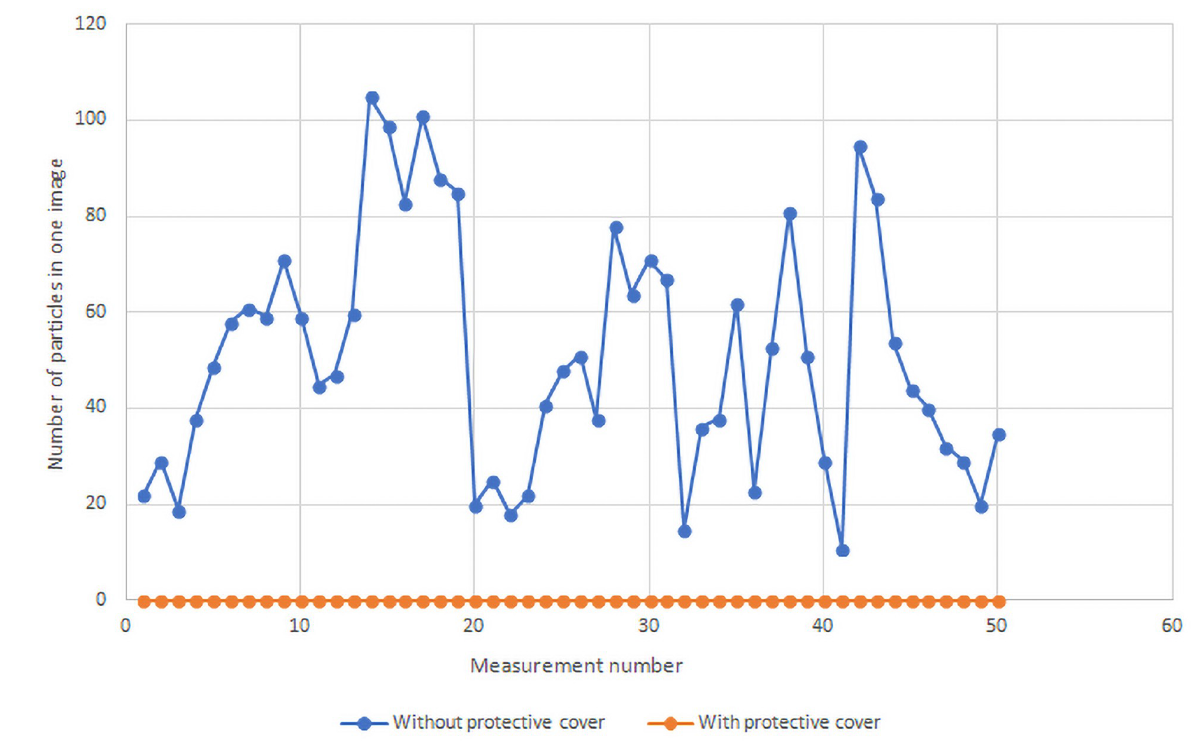
Fig 5. Number of released fluid particles. The picture shows a graph of released fluid particles from the working channel of the endoscope during our measurements (with and without the protective cover on the endoscope control body). No release of fluid particles was evident when the protective cover on the endoscope control body was